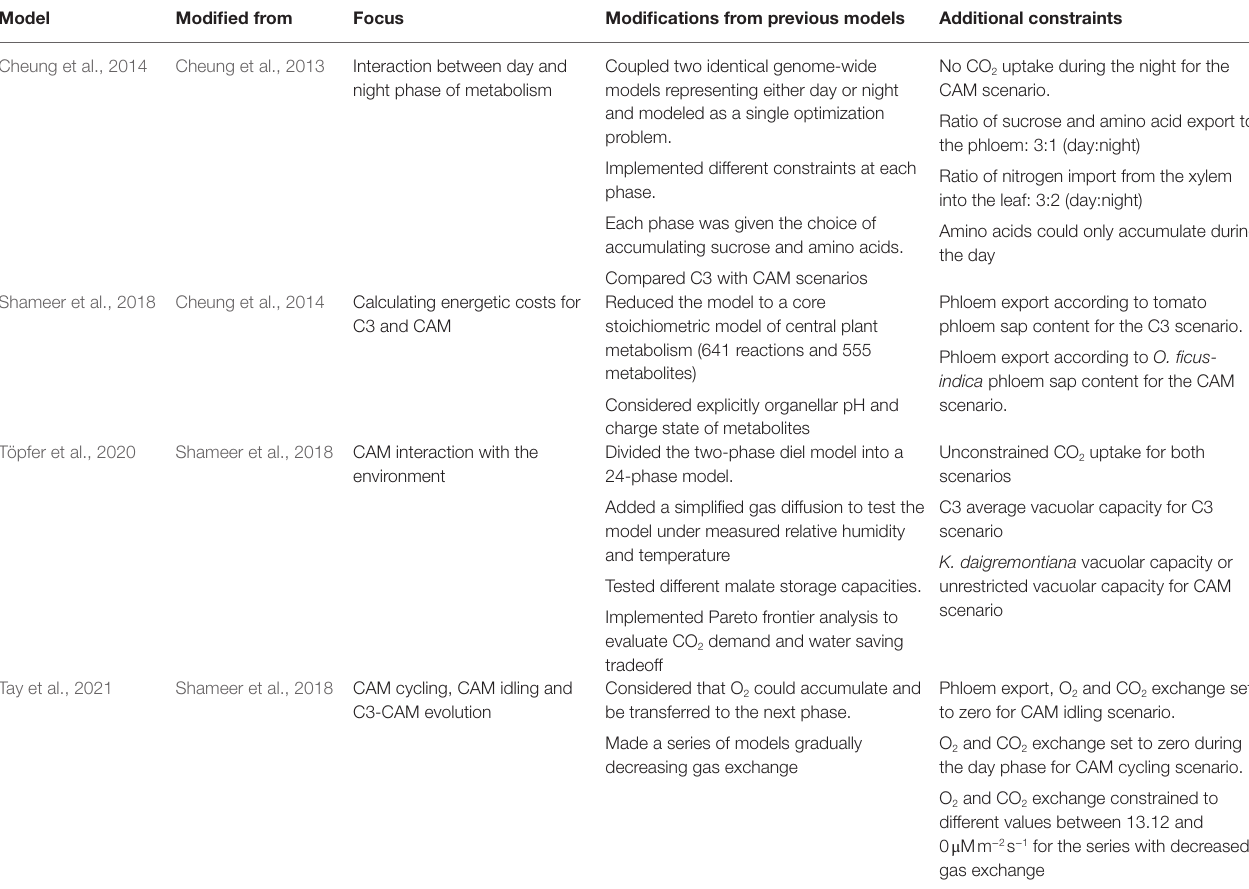
TABLE 2 | Distinctive features of FBA-based models addressing carbon flux re-distribution in